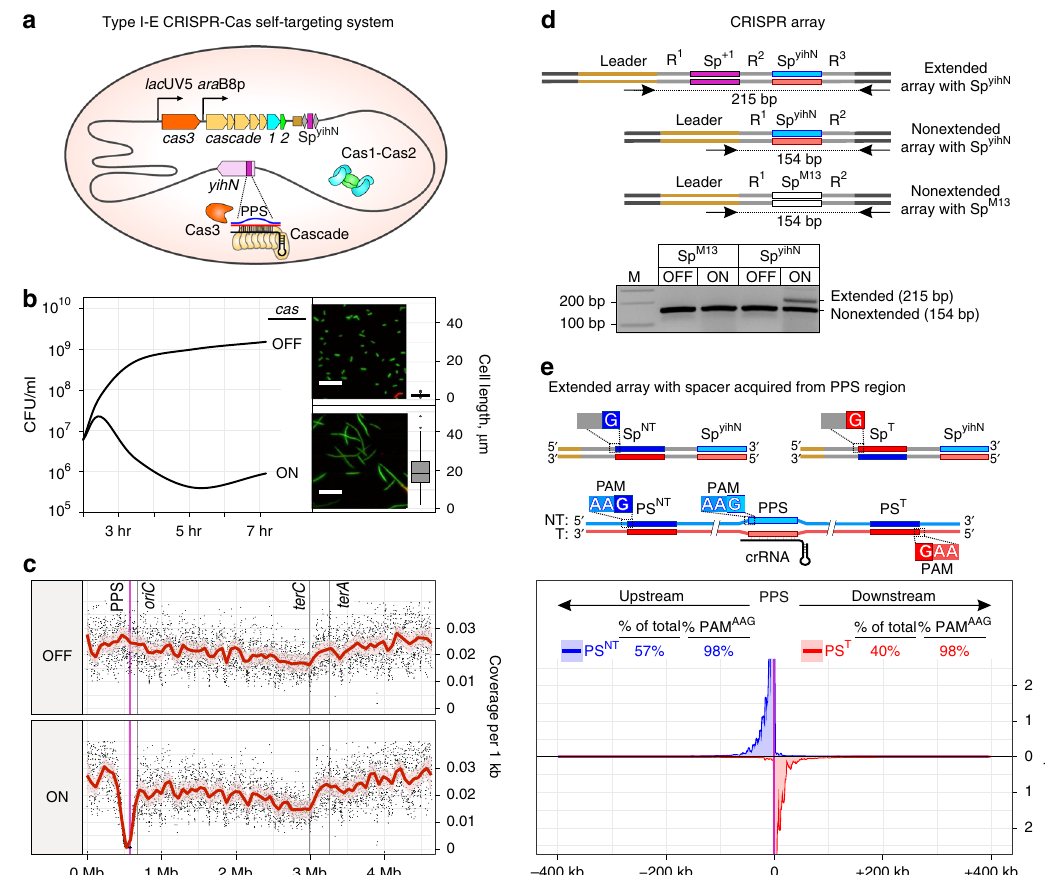
Fig. 1 Interference-driven DNA degradation coupled with spacer acquisition in a type I-E self-targeting system. a Type I-E self-targeting system. Shaded oval, E. coli cell; gray line, chromosome; orange, tan, blue, and green pentagons, cas genes; brown rectangle, CRISPR-array leader sequence; gray diamonds, repeats; purple rectangle, spacer targeting yihN (Sp yihN ); lac UV5 and ara B8p, promoters; mauve pentagon, yihN ; PPS, priming protospacer within yihN ; blue line, nontarget strand; red line, target strand; black line, crRNA. b Effect of self-targeting on cell growth. Growth curve for cultures in which cas gene expression is induced (ON) or not induced (OFF). Green, viable cells; red, non-viable cells; scale bar, 20 μ m. Boxplot: the central line, median; hinges, the fi rst and third quartiles; whiskers, 1.5 × IQR; n = 125. c Effect of self-targeting on genomic DNA content. oriC , site of replication origin; terA and terC , sites of replication termination; dot, coverage per 1 kb; red line, Loess smoothing; pink shading, 99% con fi dence interval. d Effect of self-targeting on spacer acquisition: PCR. Schematics depict an extended array containing Sp yihN and acquired spacer Sp + 1 , a nonextended array containing Sp yihN , or an array containing a spacer targeting M13 phage (Sp M13 ). Blue line, non-transcribed strand of Sp yihN ; red line, transcribed strand of Sp yihN (directs synthesis of crRNA); R, repeats. Arrows below arrays represent the positions of primers used in PCR; sizes of PCR amplicons are indicated. Results show PCR analysis of cells containing an array with Sp yihN or Sp M13 . M, double-stranded DNA marker. e Effect of self-targeting on spacer acquisition: high-throughput sequencing analysis. Top, extended arrays with spacers acquired from PPS-region protospacers. Bottom, results. Sp NT , spacer with non-transcribed strand derived from nontarget strand (NT, blue) and transcribed strand derived from target strand (T, red); Sp T , spacer with non-transcribed strand derived from target strand (T, red) and transcribed strand derived from nontarget strand (NT, blue). PS NT , protospacer for Sp NT ; PS T , protospacer for Sp T . Plot shows percentage of spacers per 1 kb derived from PS NT (blue) or PS T (red). Mean of three biological replicates is shown. Source data are provided as a